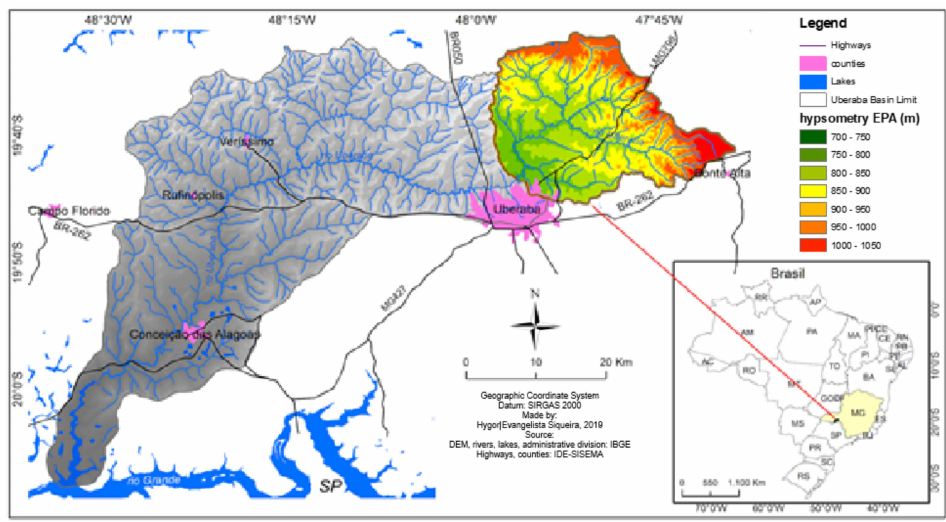
Figure 1. Experimental area of the EPA of the Uberaba River. Map Source: